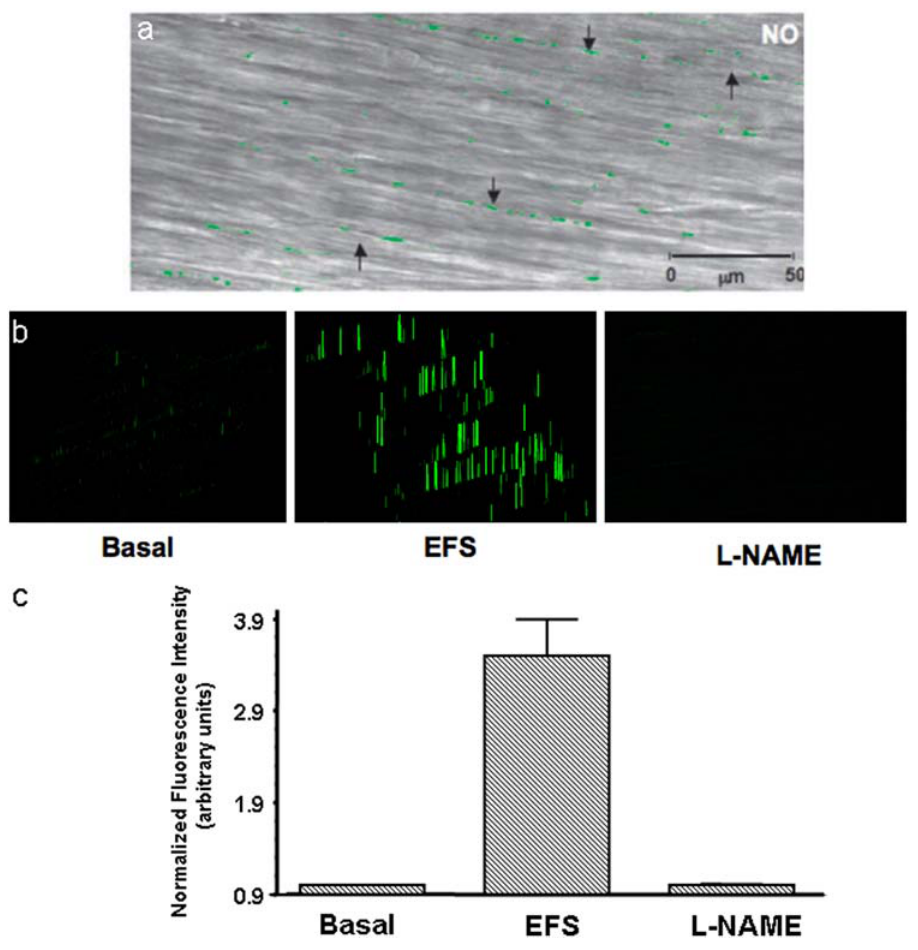
Figure 2. Visualization of NO signals in the varicosities. These studies were done after EFS of the muscle strips preloaded with NO indicator DAF-2. (a) is a low power view showing the superimposed NO fluorescent image and the image in the transmission mode. Note the green fluorescent varicosities seen along axons running in the long axis of smooth muscles. Also note that there were no NO signals in the smooth muscles. (b) Represents examples of intensity profiles of the NO signals in the unstimulated varicosities, the varicosities in the muscle strip stimulated with EFS and a muscle strip that was treated with L-NAME prior to the stimulus. (c) Represents relative quantification of the NO signals. Note very small NO signals in the unstimulated state and in stimulated state after L-NAME treatment.